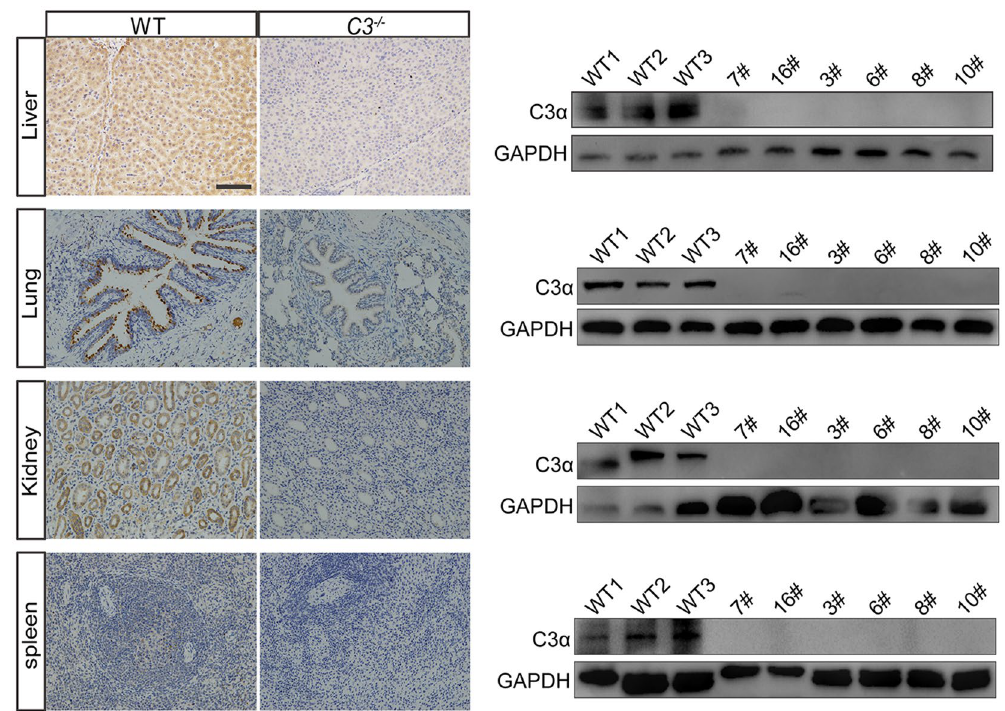
Figure 4. Immunohistochemistry (left) and western blot (right) analysis of C3 protein in various tissues. C3 protein was not detectable in liver, lung, kidney, and spleen of C3 KO piglets. Full-length blots are presented in Supplementary Figures S4–S7. The scale bar is 100 μ